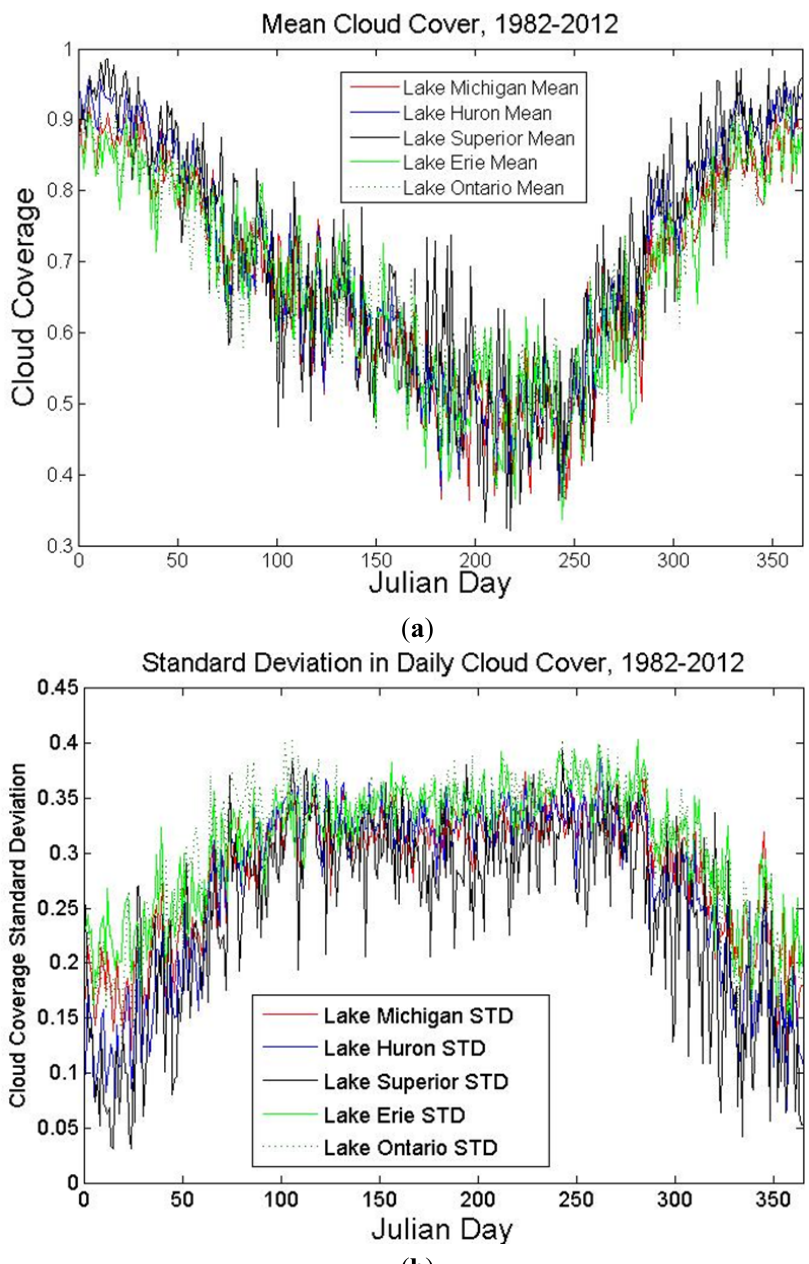
Figure 6. ( a ) The 31-year average cloud amount over each Great Lake as indicated in the legend as a function of Julian Day. ( b ) The standard deviation of the daily cloud cover for each lake as indicated in the